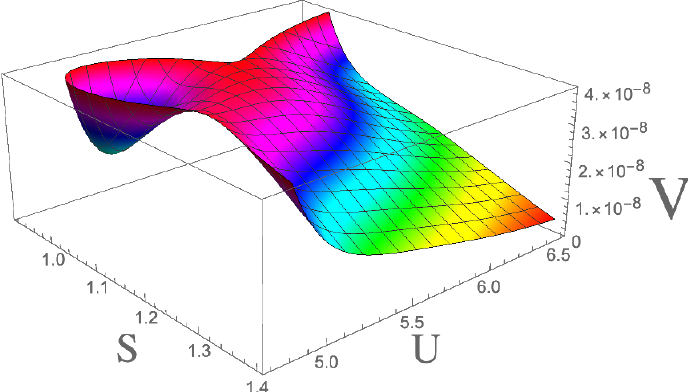
Figure 3 . The potential of the model (A.1), (A.2) for (cid:1) W = 0 and (cid:22) 2 = 4 (cid:2) 10 (cid:0) 4 in the Planck mass units. This (cid:12)gure illustrates the possibility to obtain a stable dS vacuum with large V dS by a direct uplift of the supersymmetric Minkowski vacuum. The value of V dS in this vacuum is 2 (cid:2) 10 (cid:0) 8 , which is comparable with the height of the barrier stabilizing the original Minkowski vacuum shown in (cid:12)gure